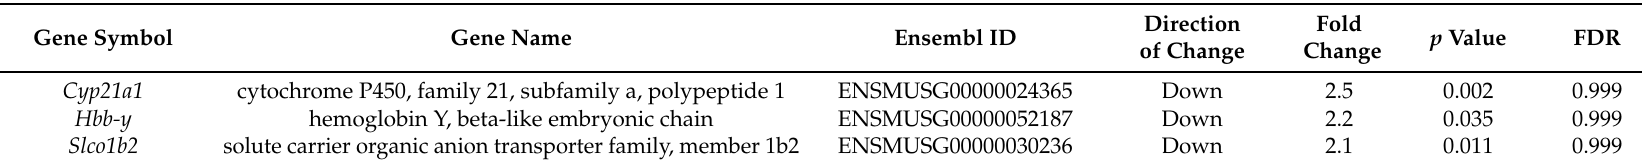
Direction Fold p Value FDR of Change Change